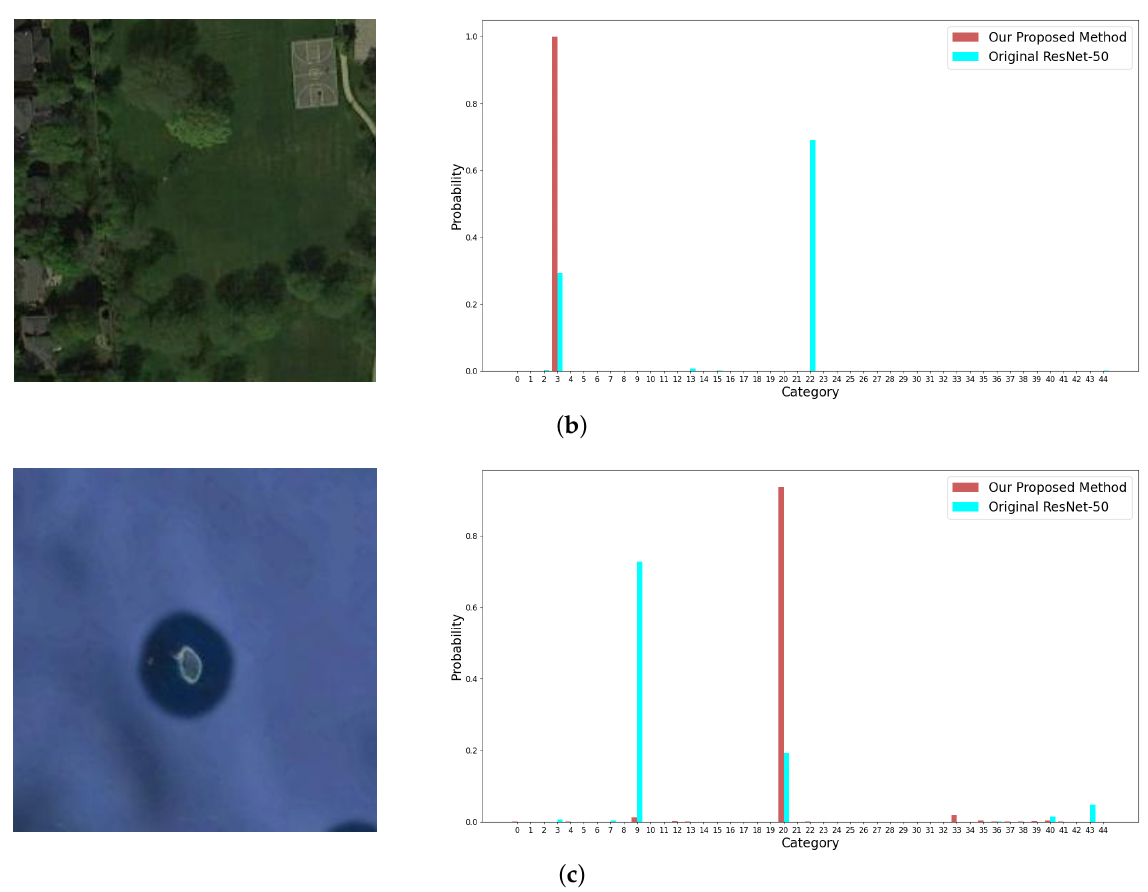
Figure 13. Examples from the NWPU-RESISC 45 dataset with small objects and the corresponding output probabilities of categories by the original ResNet-50 (plotted in blue columns) and by our proposed method (plotted in red columns). The images in ( a – c ) are labelled as airplane, basketball court, and island, respectively.